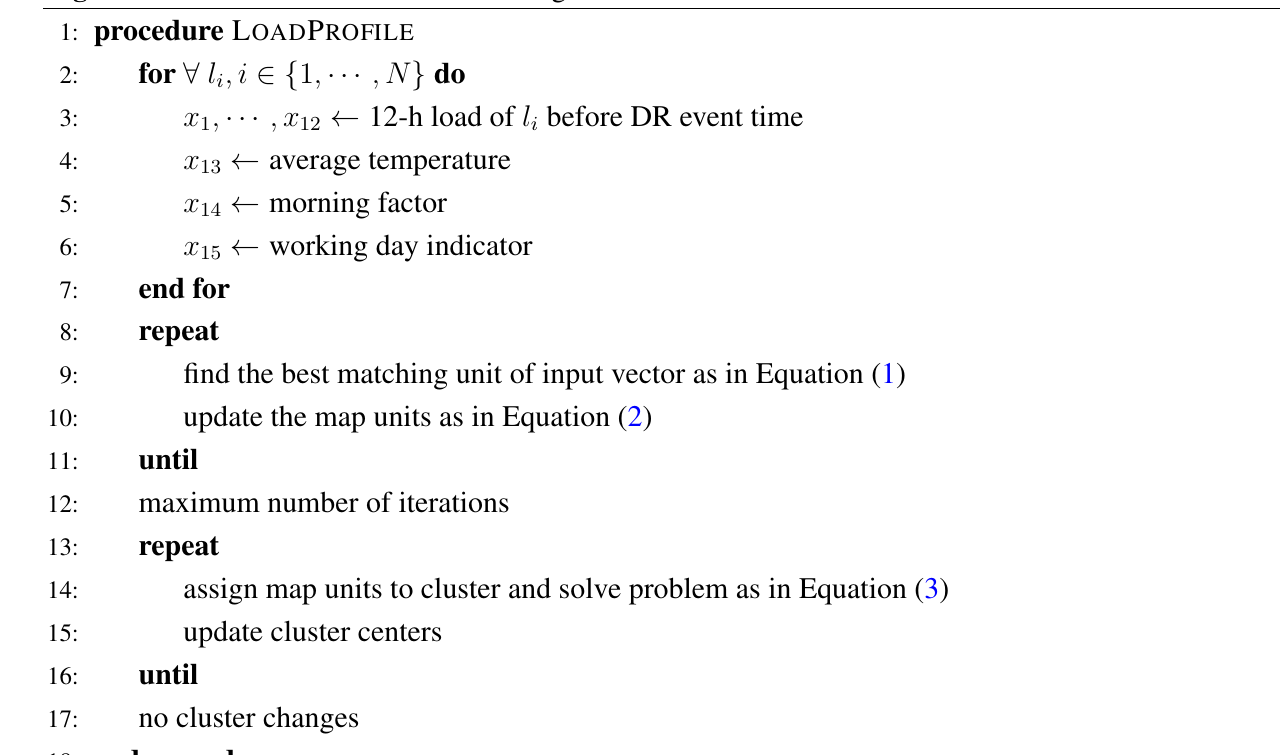
Algorithm 1 Baseline Load Estimation Algorithm